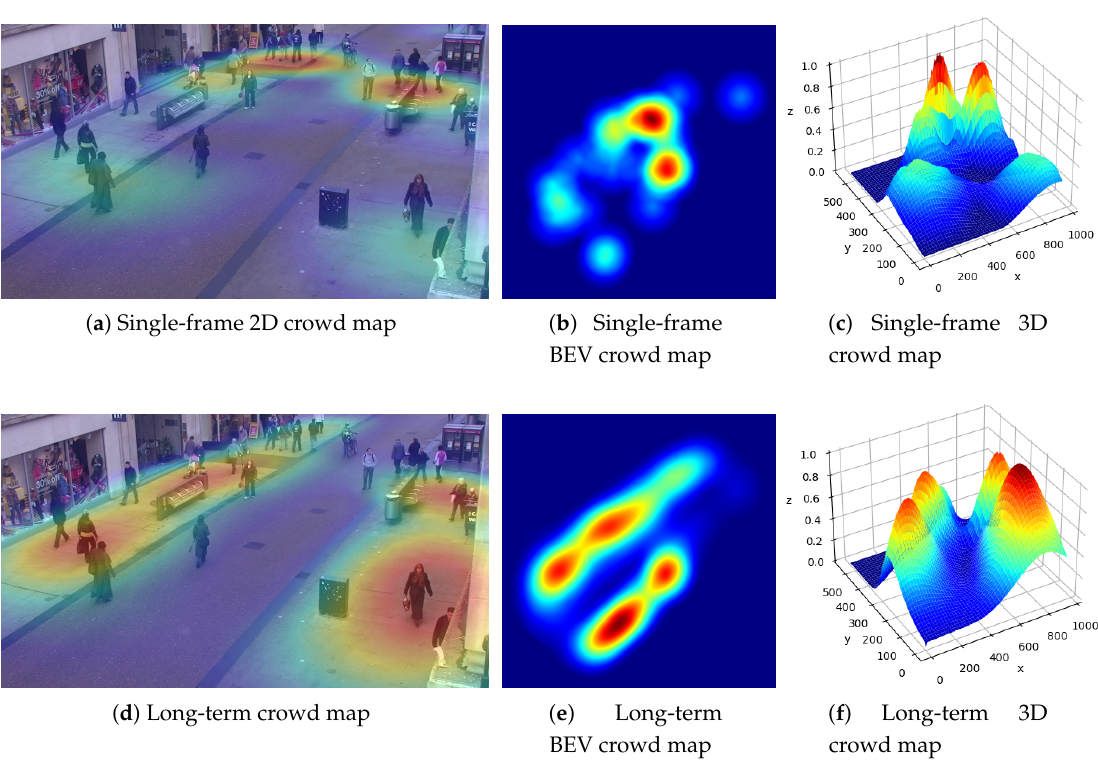
Figure 18. Single frame vs. Long-term crowd map (2D, BEV,